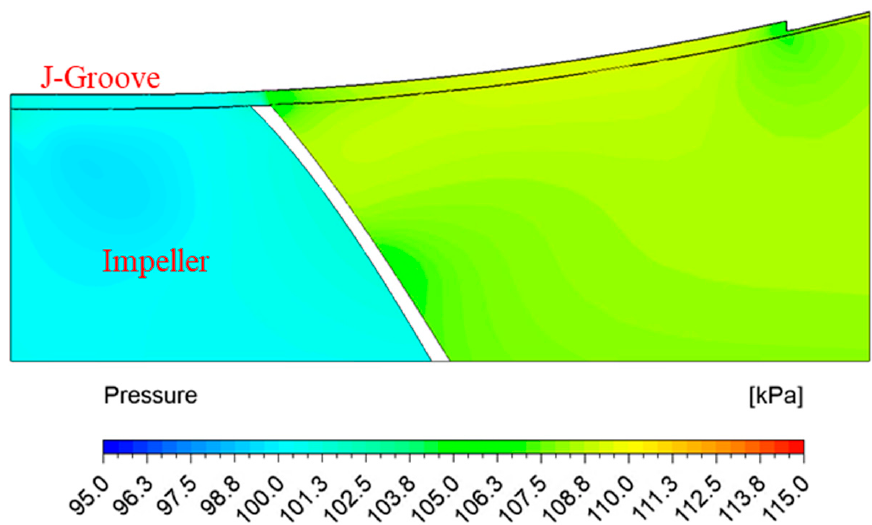
Figure 19. Pressure contours in the SCP model with J-Groove at Q/Q BEP = 1.00.